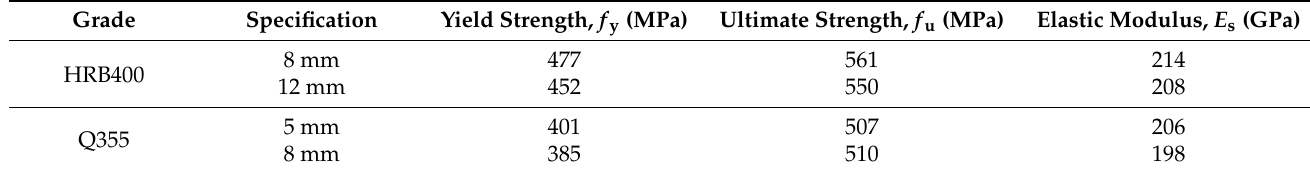
Table 3. The mechanical properties of the